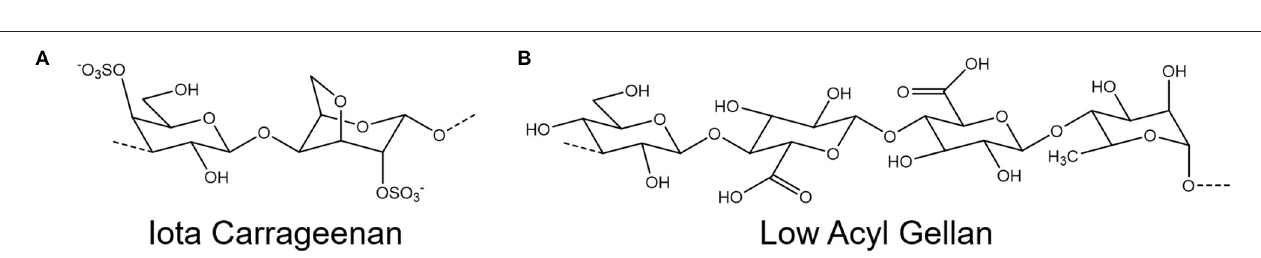
[20% (w/v)] (whilst still hot) with the mucin solution at a ratio of 1:1, giving a final concentration of 10% (w/v) gelatin and 5% (w/v) mucin. Casts were produced in the same manner as the gelatin only, and kept for 24 h prior to